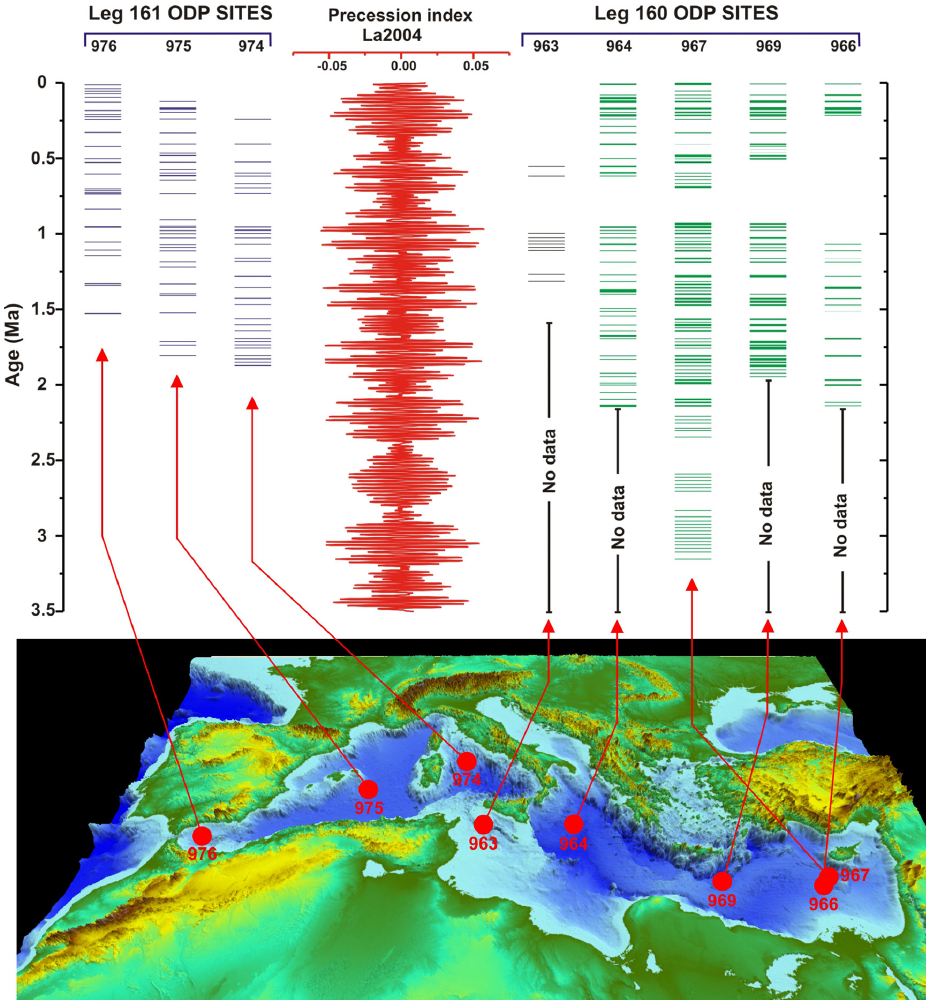
Fig. 16. Plot of sapropels and organic-rich layers (ORLs) collected in the Mediterranean Sea over the last 3.5 million years by the Ocean Drilling Program (ODP), legs 160 and 161. The chronology of sapropel layers from the central–eastern Mediterranean Sea (ODP sites 963, 964, 966, 967 and 969) follows Howell et al. (1998) and Emeis et al. (2000). The chronology of ORLs from the western Mediterranean Sea (ODP sites 974, 975 and 976) follows Murat (1999). The precession index of the same time slice is also shown (Laskar et al., 2004). Inset below: the bathymetric map of the Mediterranean Sea and the location of the ODP